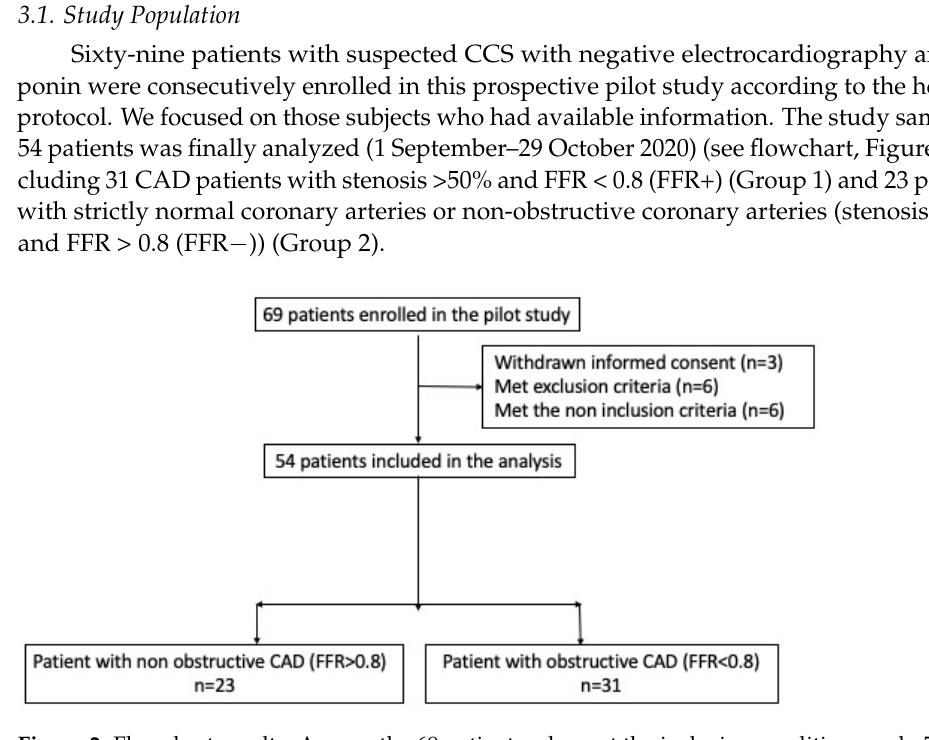
Figure 2. Flowchart results. Among the 69 patients who met the inclusion conditions, only 54 were finally able to be selected for the pilot study.